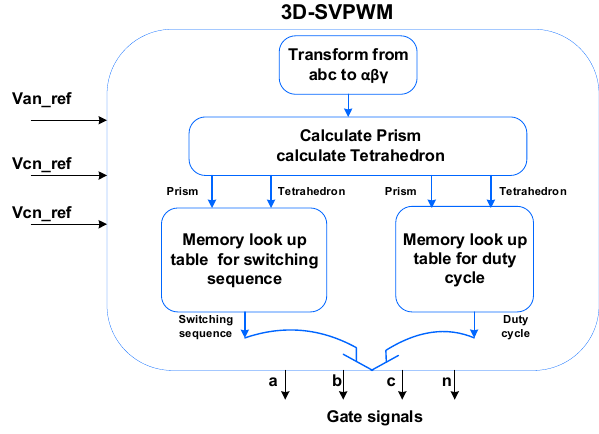
Figure 3. The algorithm of the 3D-SPVPWM.